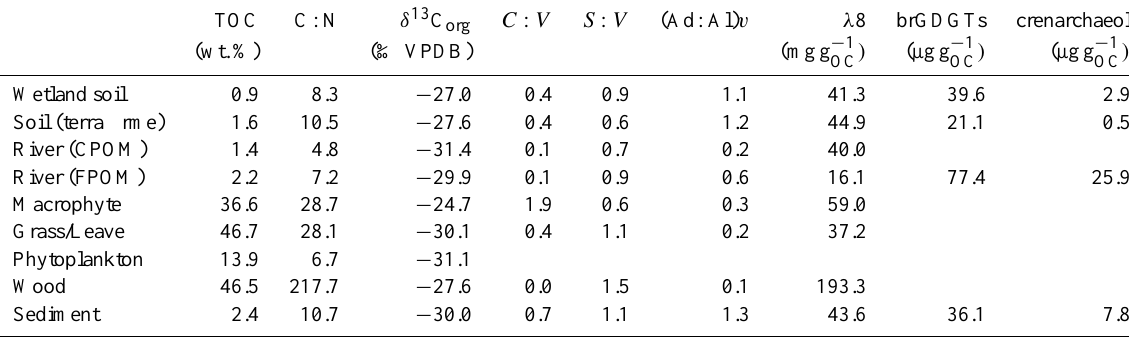
) (µgg − 1 ) (µgg − 1 ) OC OC OC